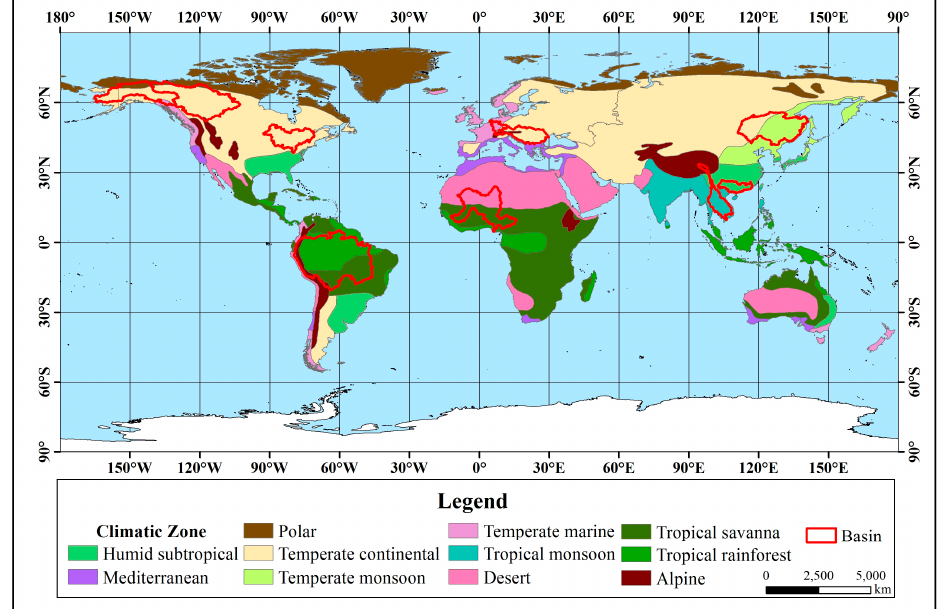
Figure 4. Distribution with a significant downward trend in river discharge.